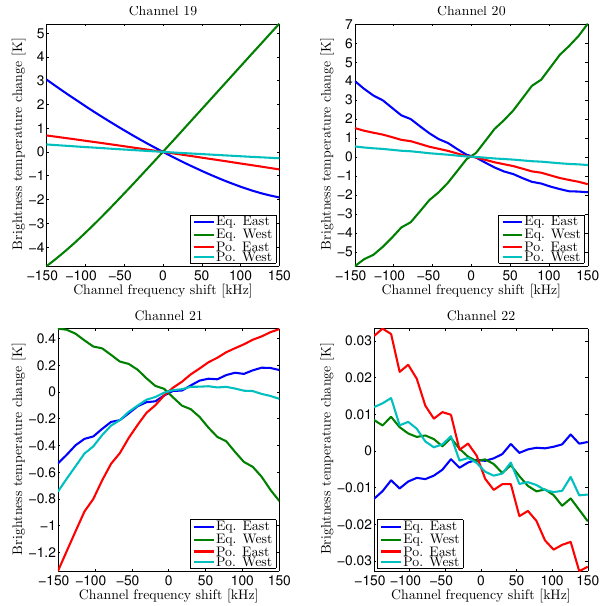
Figure 4. Changes in brightness temperatures introduced by an off- set in channel frequency for a single atmospheric scenario. This fig- ure shows the changes in channel brightness temperatures for the simulations in Fig. 3; both legends and line colors represent the cases in Fig. 3. The 0kHz brightness temperature has been used as reference (hence 0K at 0kHz). The title of each subplot shows the